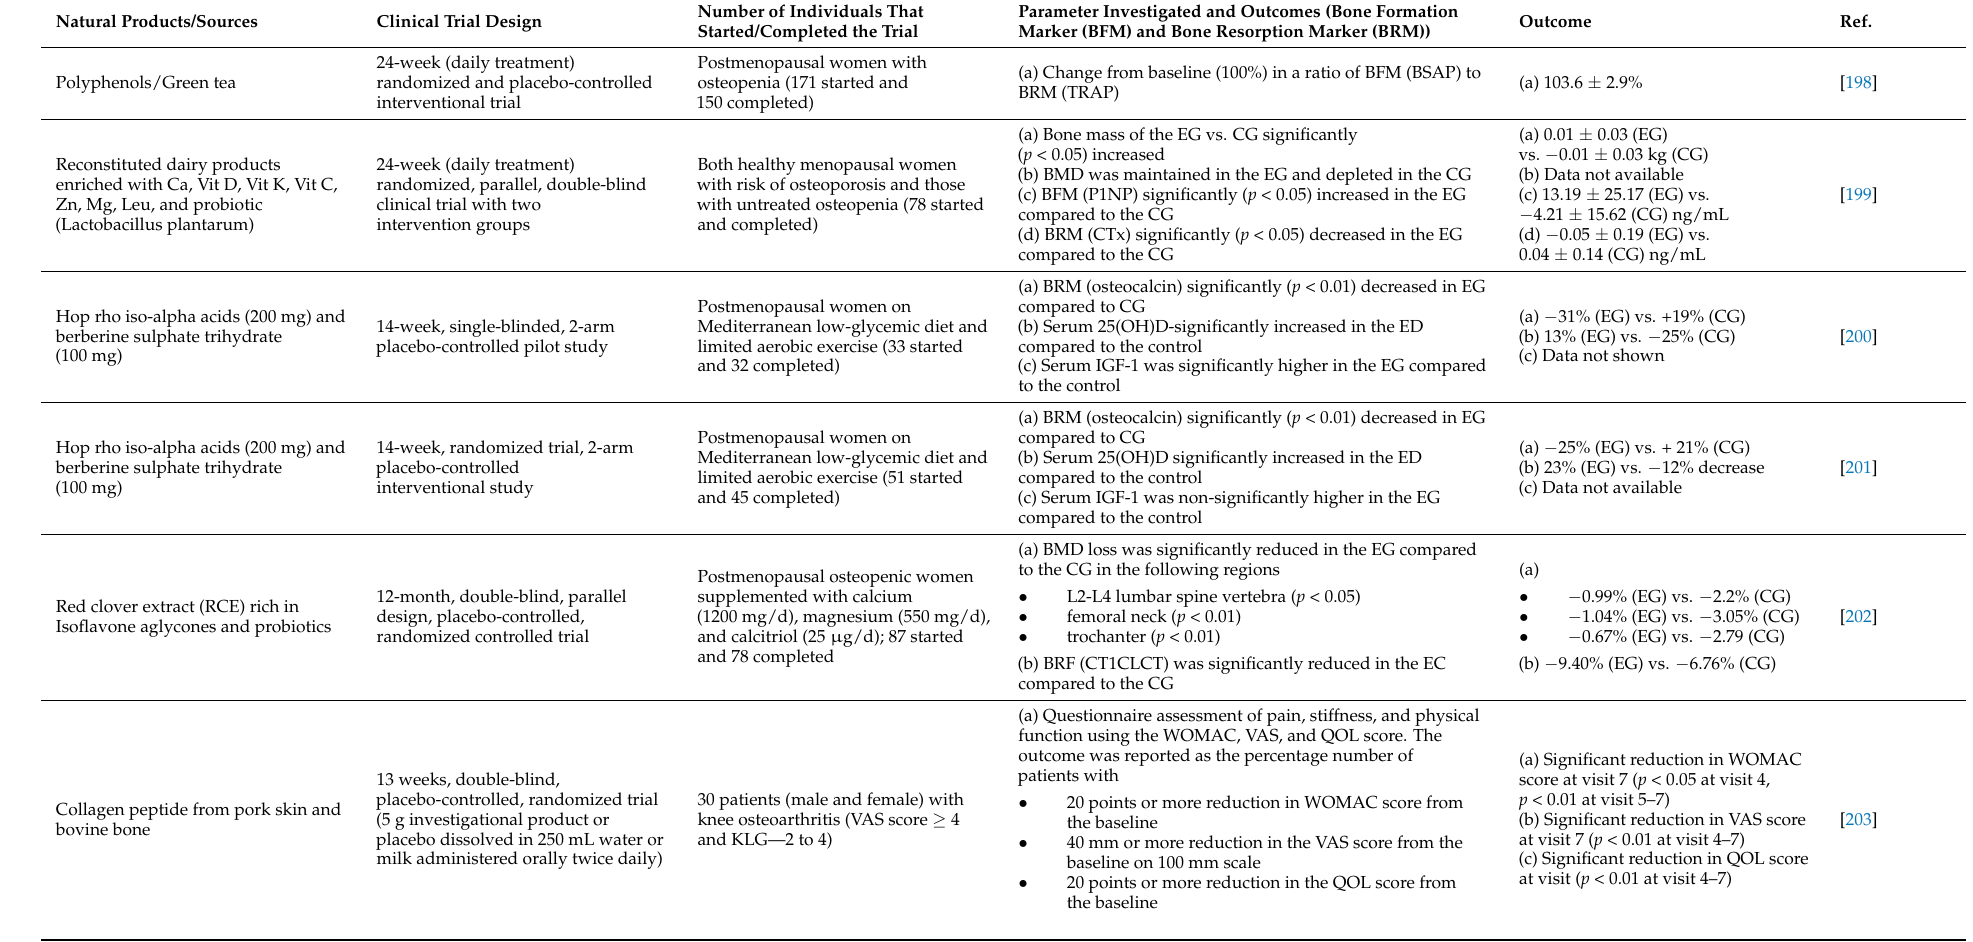
Table 4. Clinical studies on humans illustrating the bone health-improving effects of natural